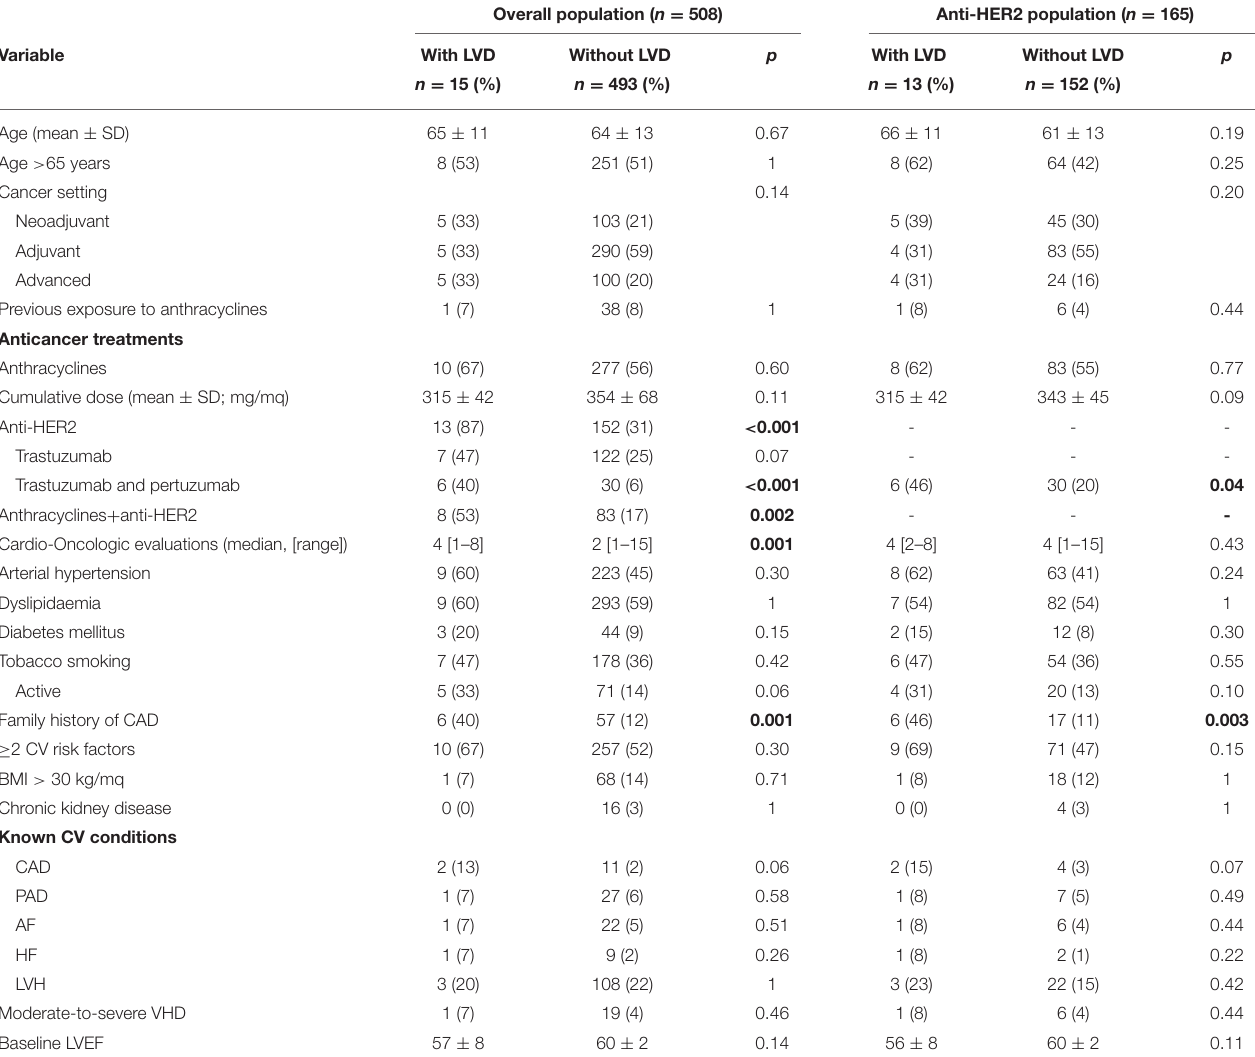
TABLE 2 | Characteristic of BC patients with and without LVD. Overall population ( n = 508) Anti-HER2 population ( n =